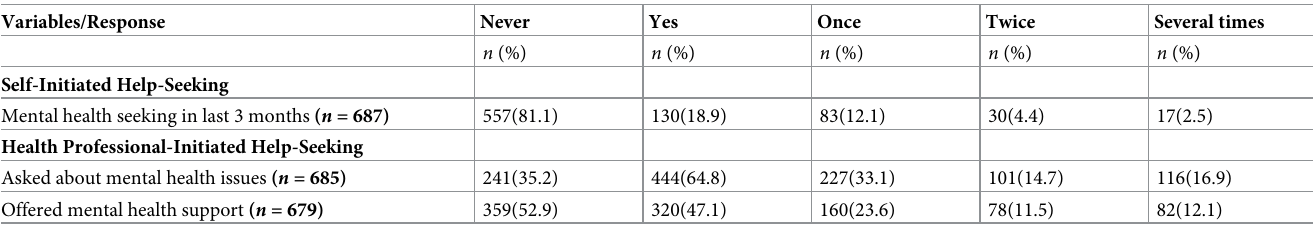
Table 1. Prevalence of self and health professional-initiated help-seeking for mental health among pregnant women (n = 702).